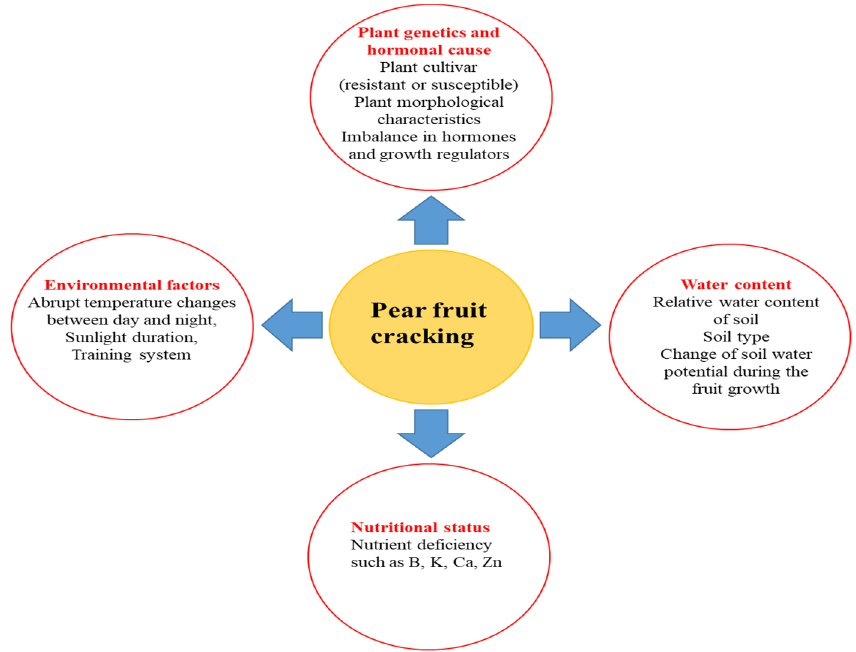
Figure 2. Factors responsible for pear fruit cracking.